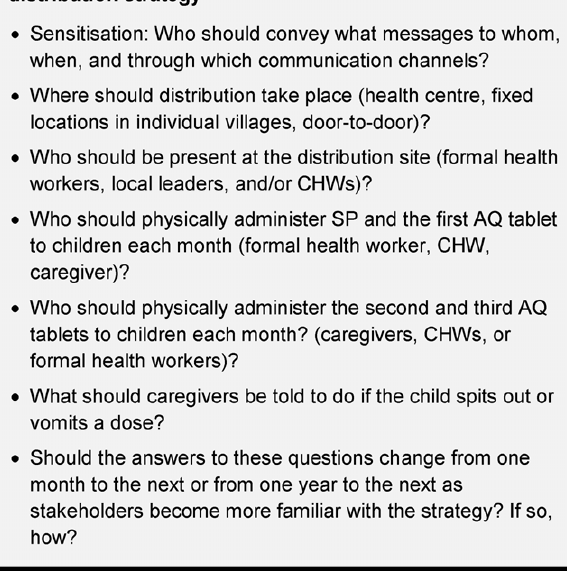
Figure 3. Questions to consider in planning an IPTc distribu- tion strategy.